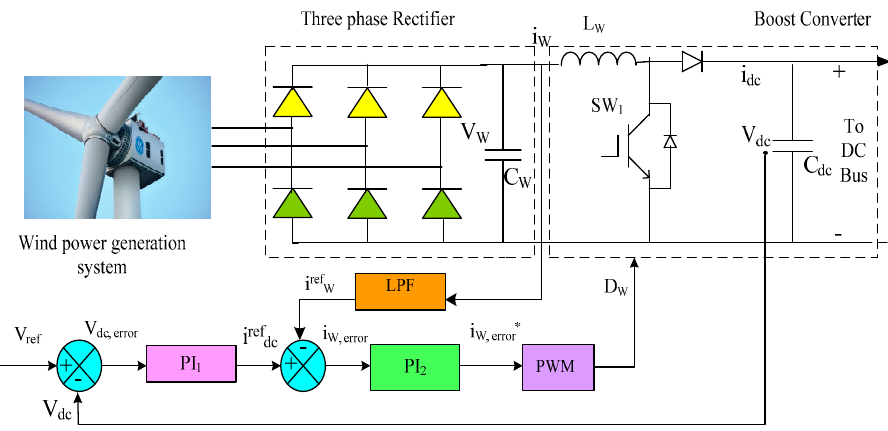
Figure 3. Wind System with